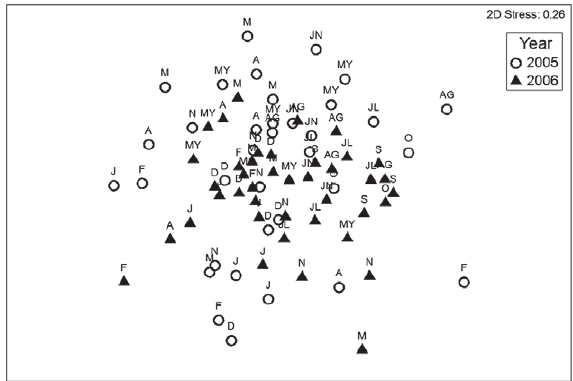
Fig. 4. – Non-metric multidimensional scaling ordination based on the Bray-Curtis similarity matrix of decapod larval abundance, us- ing all samples collected in 2005 and